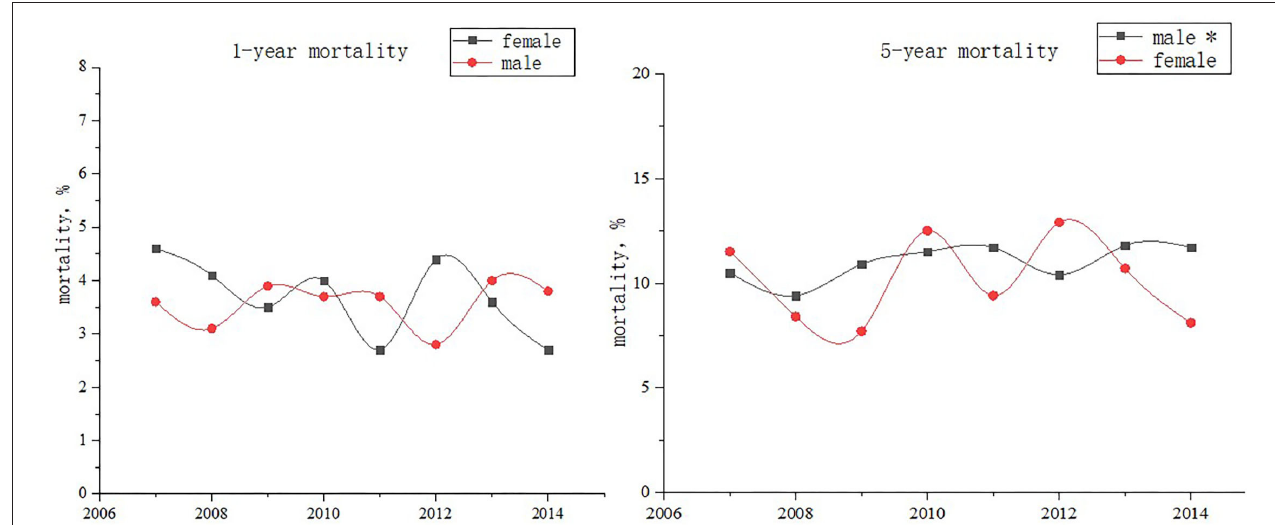
FIGURE 3 | 1-year and 5-year mortality among patients with coronary artery disease stratified by sex between 2007 and 2014. * p for trend < 0.001.